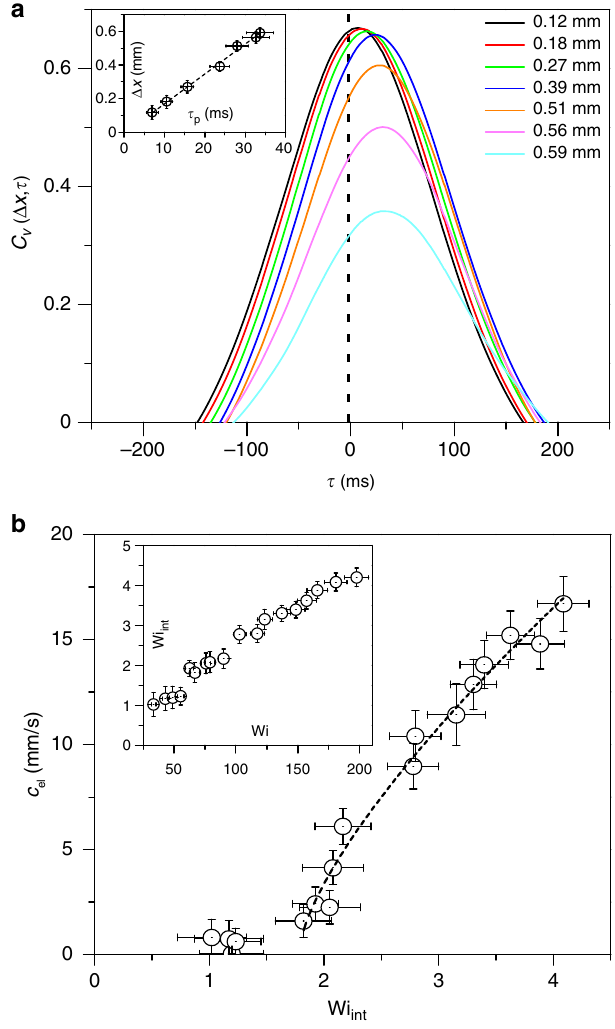
Fig. 5 Elastic wave speed versus Wi int . a Cross-correlation functions of the cross-stream velocity C v ( Δ x , τ ) versus lag time τ for different values of Δ x , obtained at y / R = 0.18 and for Wi = 148.4. Inset: Δ x versus τ p for Wi = 148.4, and a slope of linear fi t to it (shown by dashed line) provides c el . The error bars on Δ x are determined by the spatial resolution of measurements, and for τ p they are estimated based on the s.d. of gaussian fi t of C v ( Δ x , τ ). b Dependence of c el on Wi int , where the dashed line is a fi t of the form (cid:4) (cid:5) β , where A = 8.9 ± 1.2 mm s − 1 , β = 0.73 ± 0.12, and c ¼ A Wi (cid:5) Wi c el int int ¼ 1 : 75 ± 0 : 2. Inset: Wi c onset value Wi c int versus Wi. The error on el is int estimated based on the s.d. of the linear fi t of Δ x versus τ